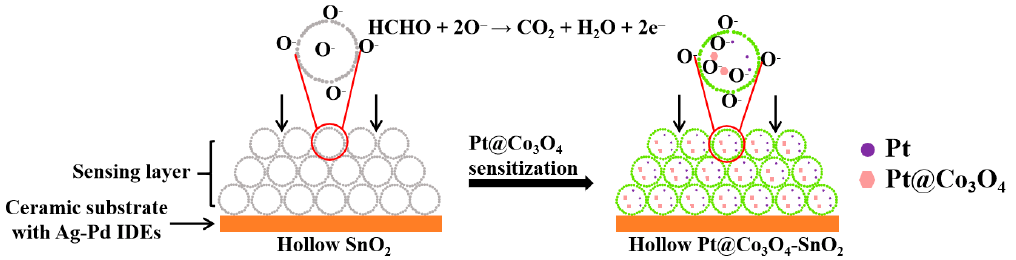
Figure 10. Schematic diagram of the sensing principle of SnO 2 and Pt@Co 3 O 4 -SnO 2 hollow microspheres.